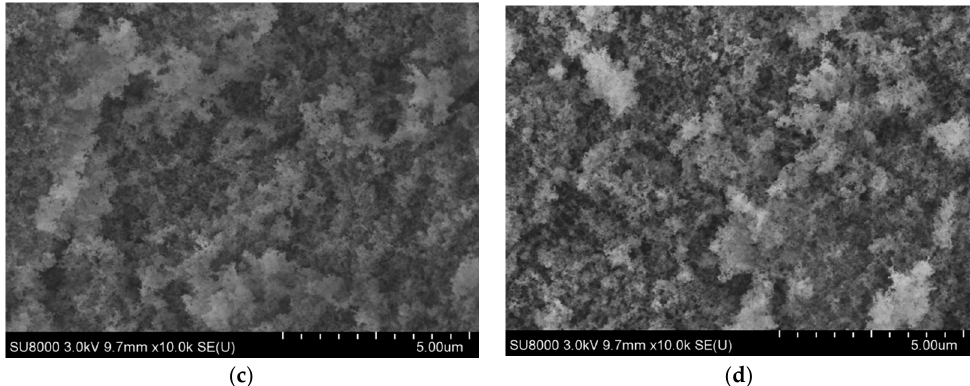
Figure 2. SEM images of nanosilica and three hydrophobic nanosilica materials at magnifications of ×10,000. ( a ) Silica; ( b ) OCS-Silica; ( c ) SOC-Silica; ( d ) SCA-Silica.